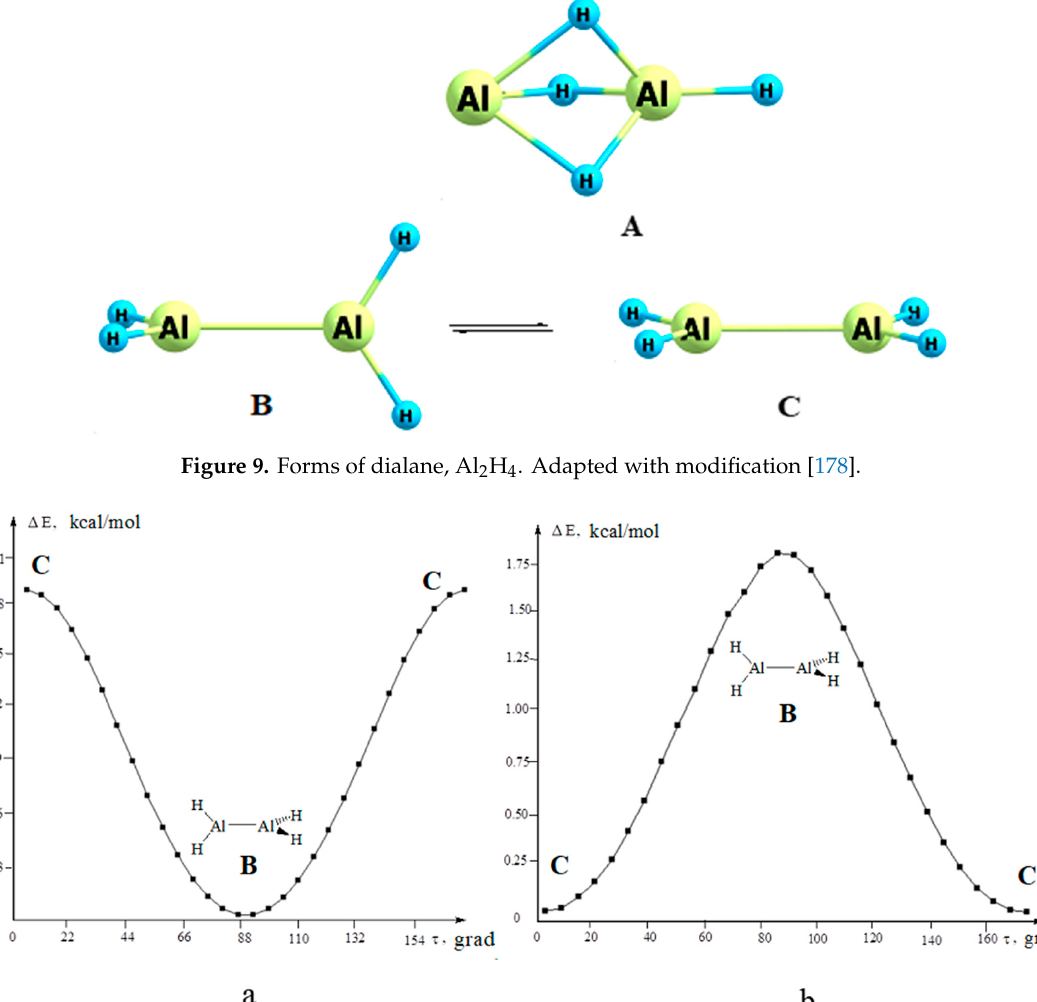
Figure 10. Relative energy of dialane Al 2 H 4 as a function of the H–Al–Al–H torsion angle τ (0 K). ( a ) free molecule; ( b ) cluster Al 2 H 4 @(5,5). Adapted with modification [178].